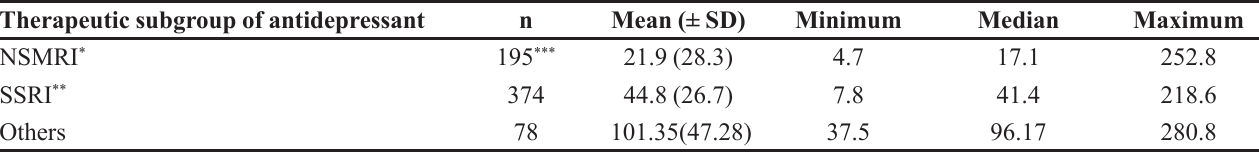
TABLE II - Monthly treatment cost (R$) according to therapeutic subgroup of antidepressant prescribed. Pharmacy of the Civil Servants’ Clinic (CLISERV) of the Municipal Government of Belo Horizonte, Minas Gerais, Brazil, 2005 Therapeutic subgroup of